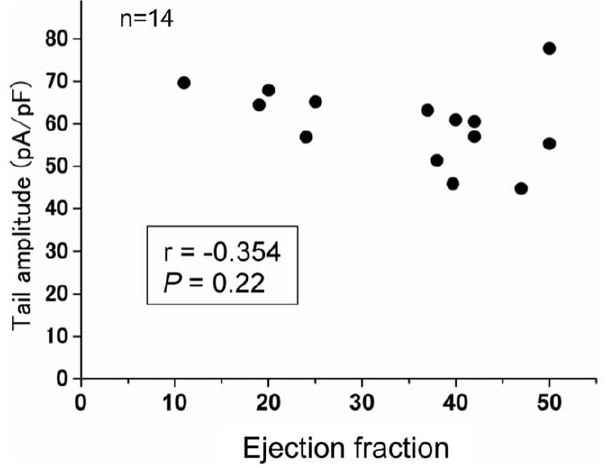
Figure 2. Relationship between peak tail amplitude and ejection fraction in the overall HF patients .